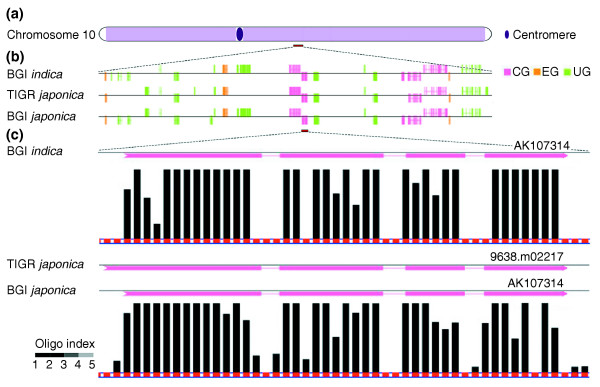
Tiling microarray analysis of the rice chromosome 10 transcriptome. (a) Schematic representation of rice chromosome 10. The purple oval denotes the centromere. (b) A region from the long arm of chromosome 10 displaying the three sets of gene models used: BGI indica; TIGR japonica and BGI japonica. The nonredundant protein-coding gene models are aligned to the chromosomal sequences and color-coded on the basis of their classification (see text). (c) Detailed tiling profile of one representative CG model. The model is represented here as block arrows, which point in the direction of transcription. Signal oligos are aligned according to their chromosomal coordinates. The fluorescence intensity value of each signal oligo, capped at 2,500, is depicted as a vertical bar. The shade of the bar represents the oligo index score (see Materials and methods). The red blocks underneath the bars indicate the presence of an interrogating oligo in the microarray.